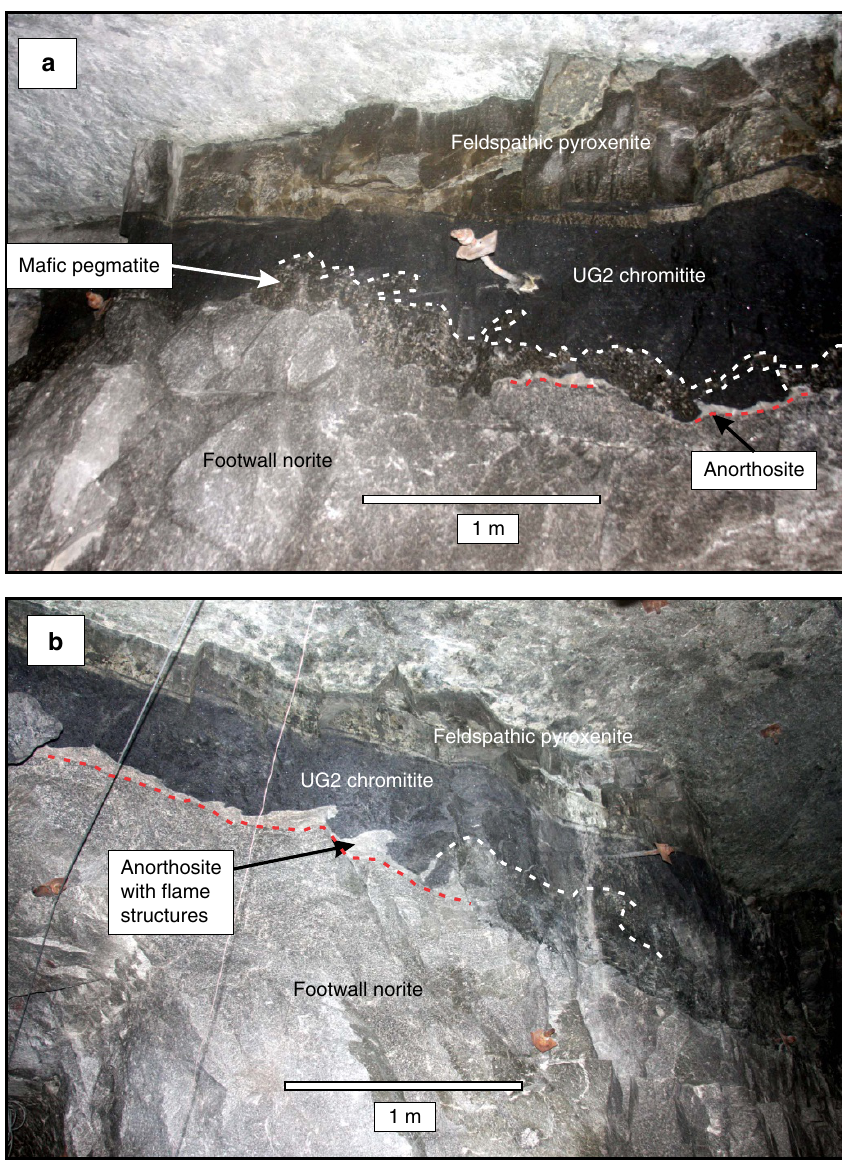
Figure 4 | Underground exposure of the base of the UG2 chromitite (black) at Modikwa mine. This exposure is in a pothole environment without lower pyroxenite. Contacts between anorthosite and underlying norite are emphasized with dashed red lines. Contacts between mafic pegmatite and chromitite are emphasized with dashed white lines. Scale bars are 1m. ( a ) The contact is lined with anorthosite (white) or with mafic pegmatite. Randomly placed drill holes can be expected to encounter one or the other unpredictably. The mafic pegmatite is rooted on the footwall norite but forms irregular masses penetrating deep into the overlying chromitite. ( b ) Anorthosite shows flame structures against overlying chromite, suggesting incipient gravitational instability that could be stretched into sheath folds by layer-parallel shearing during sill